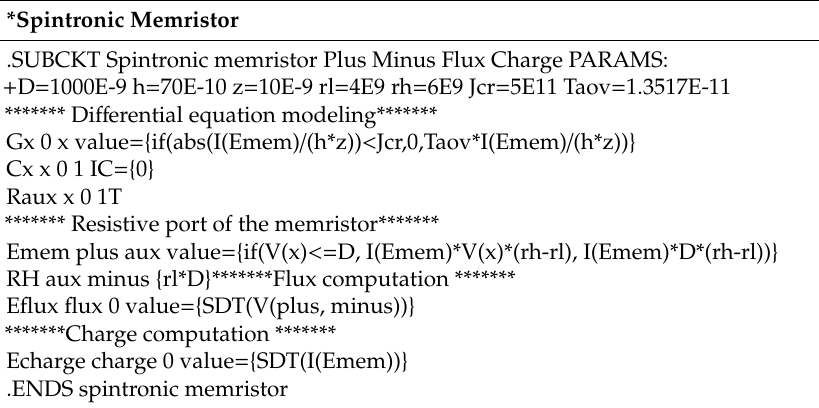
Table 1. Spice model description for spintronic